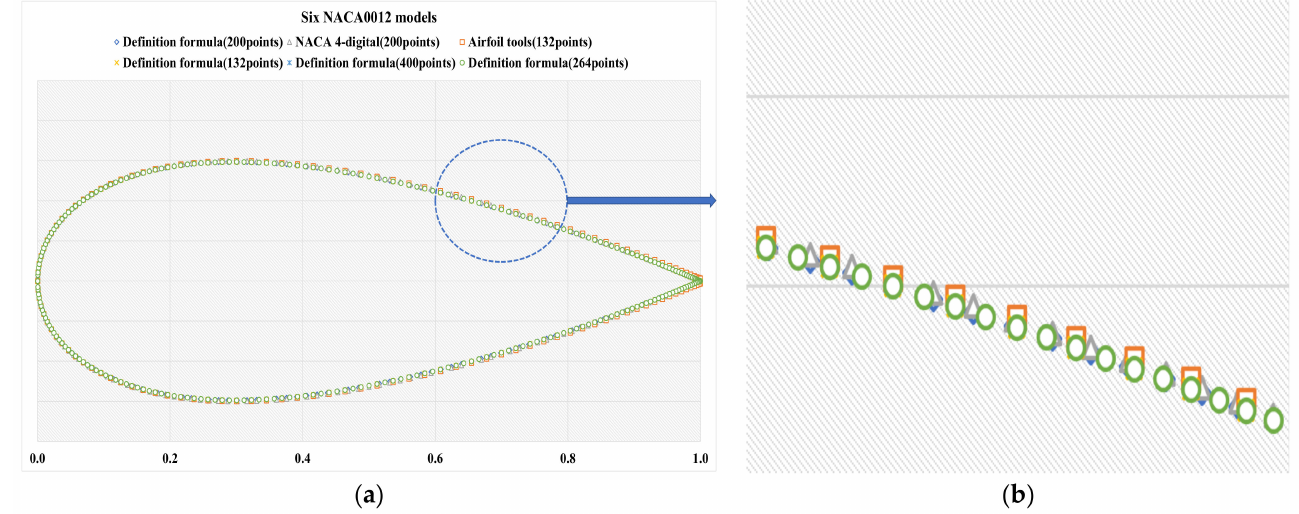
Figure 1. ( a ) Six NACA0012 airfoil models; ( b ) close view of different